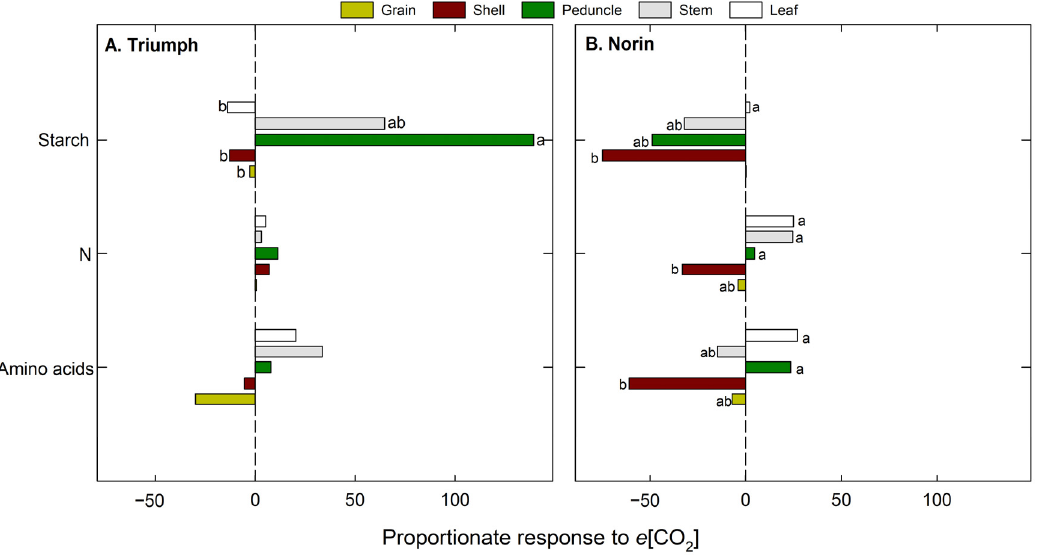
Figure 5. Percentage (%) of change under e [CO 2 ] relative to a [CO 2 ] in five organs evaluated (stems, leaves, peduncles, shells, and grain) at maturation in both wheat cultivars: ( A ) Triumph and ( B ) Norin. The letters indicate significant differences between organs ( p < 0.05).